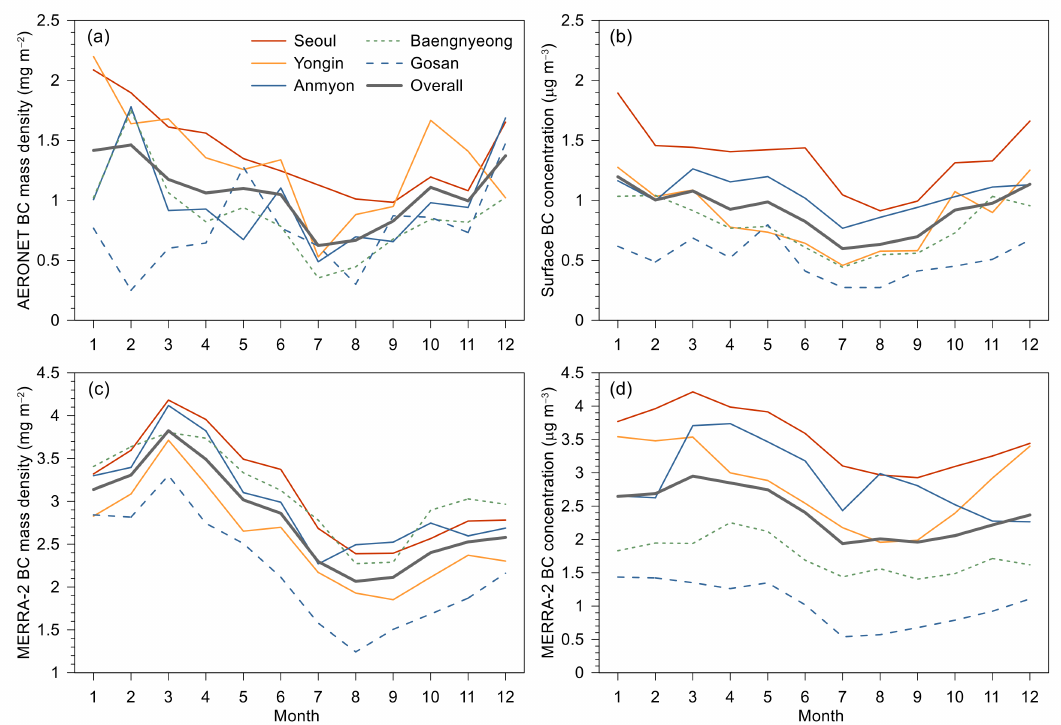
Figure 5. Monthly variation in the ( a ) estimated AERONET columnar BC concentration (mg m − 2 ), ( b ) in situ BC concentration ( µ g m − 3 ). ( c ) and ( d ) MERRA-2 columnar (mg m − 2 ) and surface BC concentration ( µ g m − 3 ),